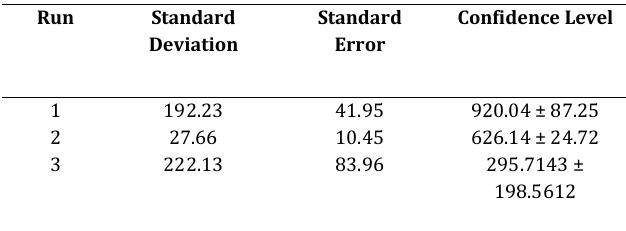
Figure 3: (a) Voltage reading for the 20 grams of orange peel, (b) Voltage reading for the 40 grams of pineapple peel Table 3 (a): Statistical analysis of the optimum concentration orange peel substrate